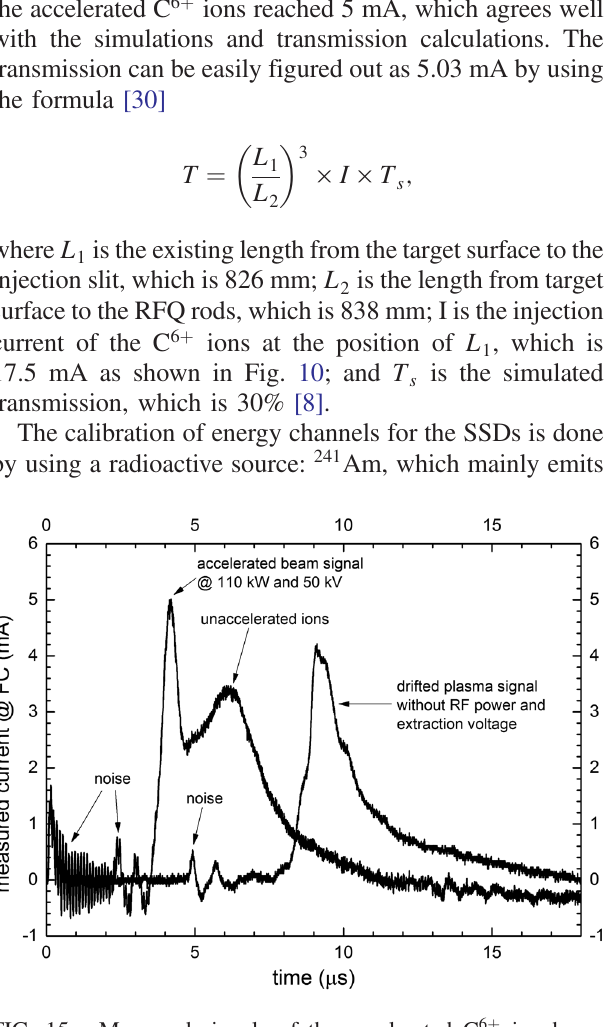
FIG. 15. Measured signals of the accelerated C 6 þ ion beam current and the unaccelerated ion beam current.